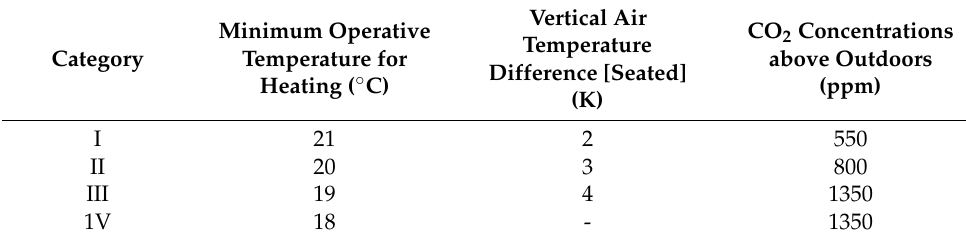
Table 3. Design criteria for thermal comfort, temperature stratification, and CO 2 concentration according to EN 16798-1